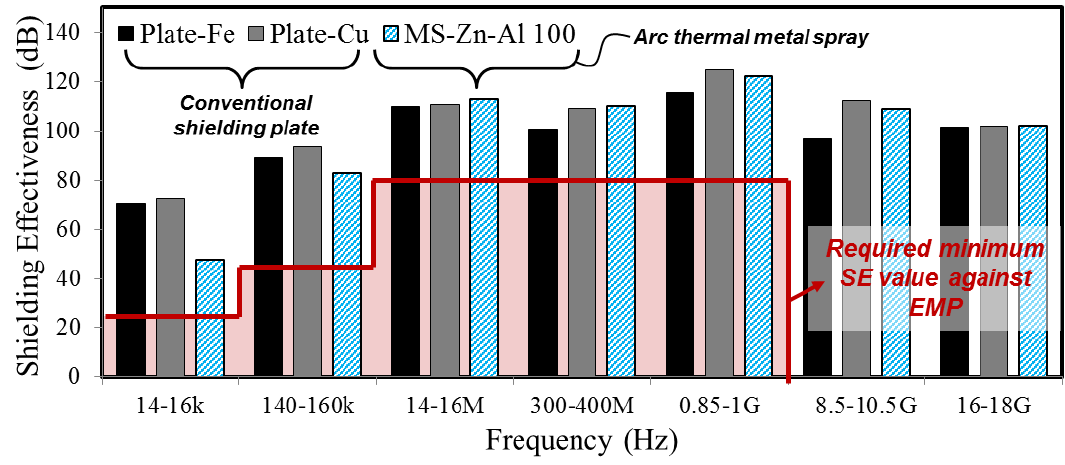
Figure 9. SE test result between metal plate and ATMS coating by Zn-Al.